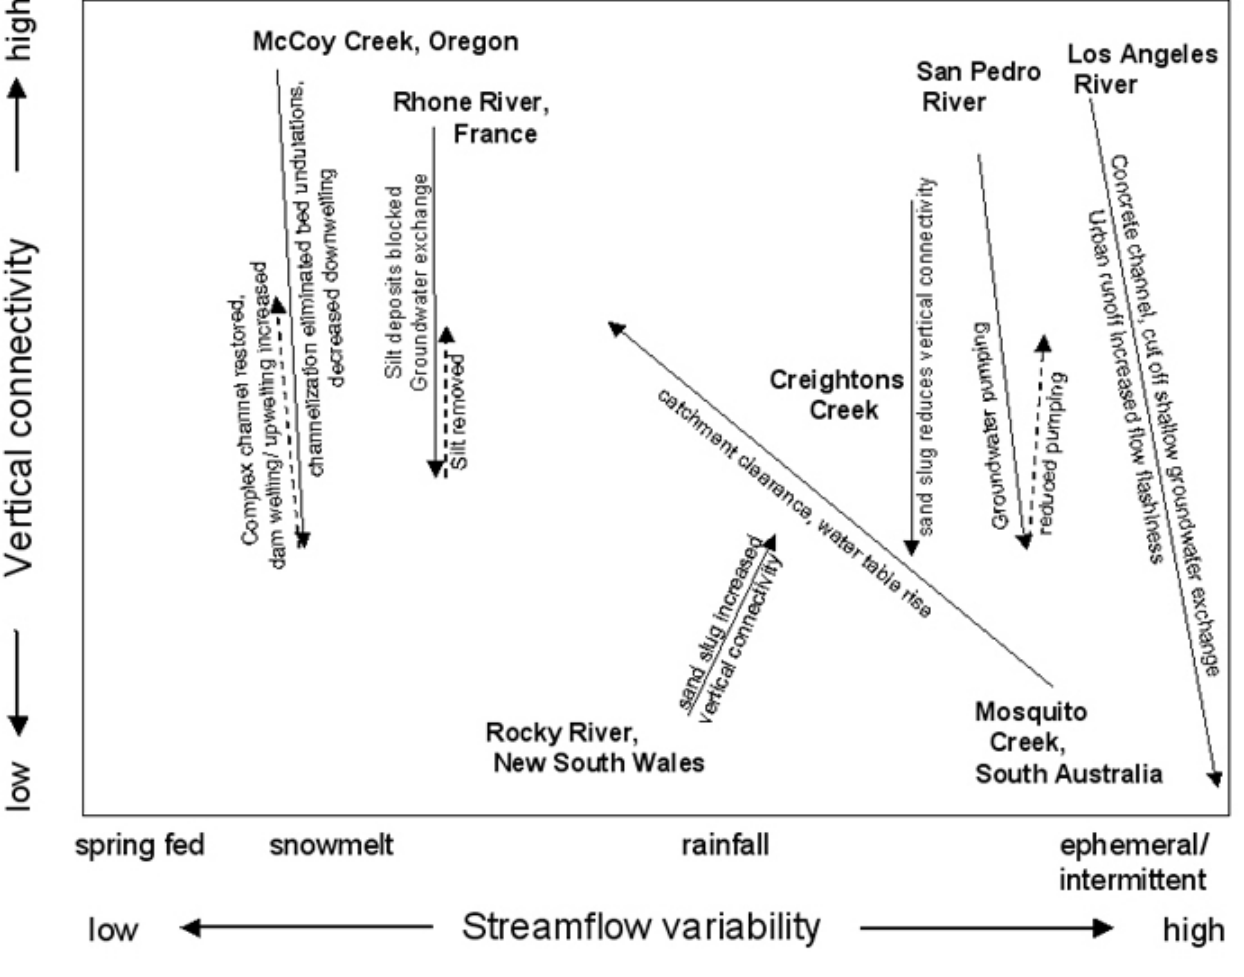
Fig. 3. Solid arrows represent ecological degradation and dashed arrows represent restoration trajectories plotted on axes of vertical connectivity and flow dynamics. See Appendix 1 for a discussion of